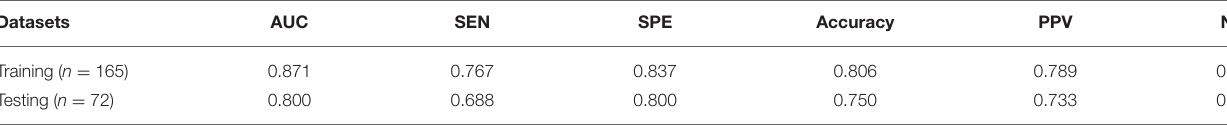
TABLE 7 | The predictive performance of radiomic classifier in training and validation sets.